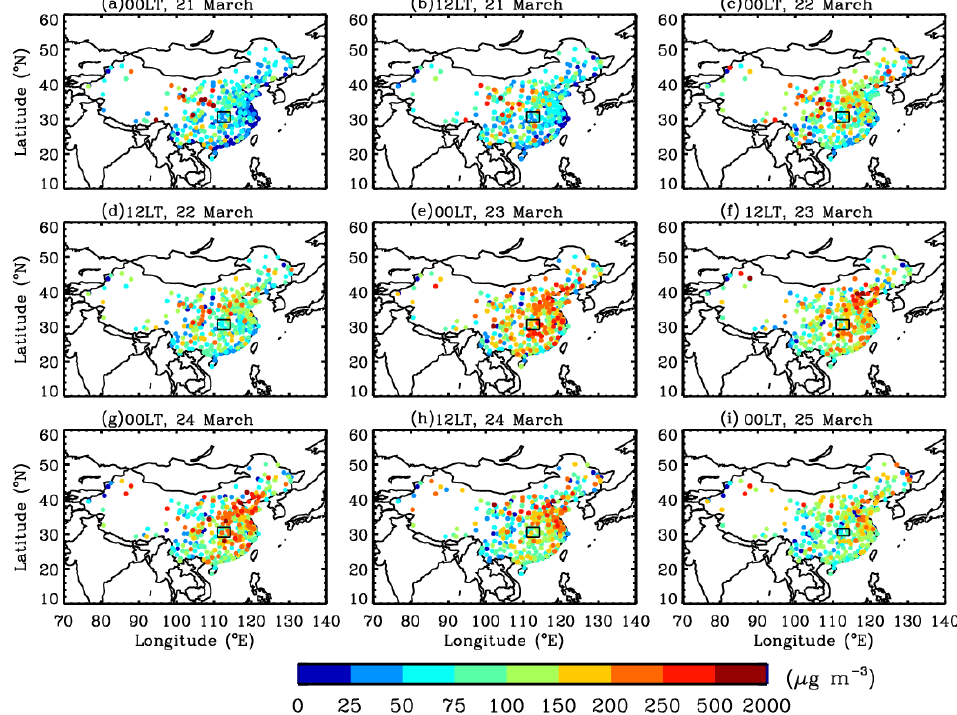
Figure 7. Evolution of surface-observed PM 10 concentrations over mainland China from 21 March to 25 March 2018. The location of the Jianghan Plain is marked by black rectangles.